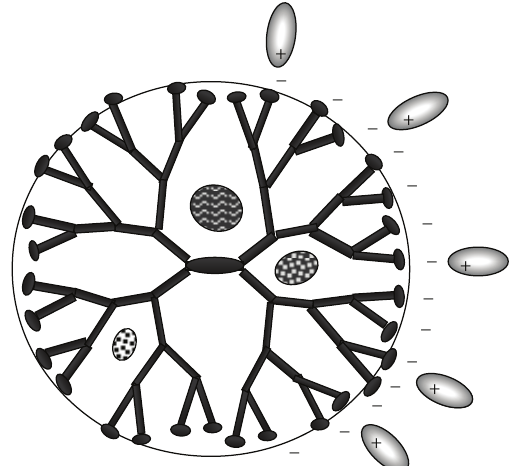
Figure 6: Possible mechanism of interaction between dendrimers and drugs